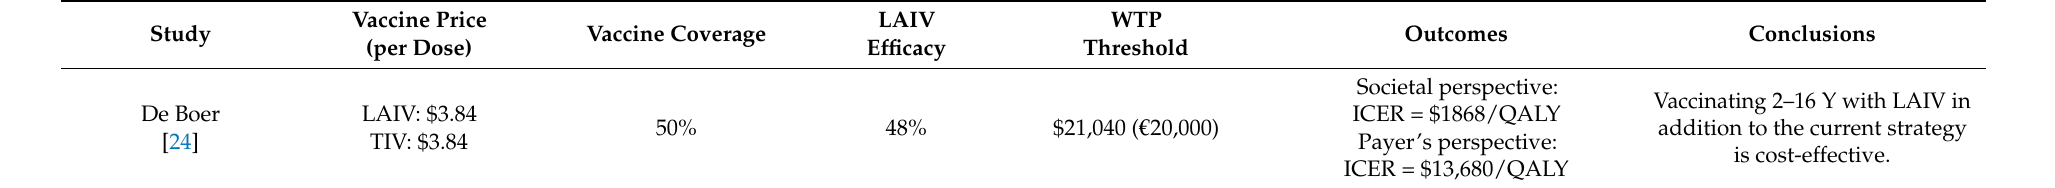
Table 2. A summary of the results of the included